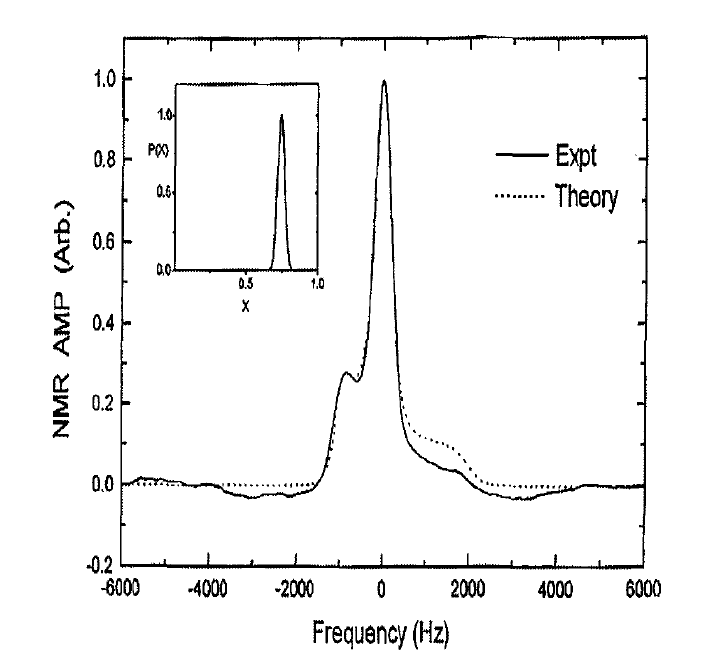
Figure 12. Comparison of observed NMR absorption line shape at 4.2 K with the calculated NMR absorption line shape for long-range Pa3 ordering for pure solid 15 N 2 . The inset shows the order parameter distribution P ( σ ) that was used. Reproduced with permission from [38]. Copyright Springer Nature,